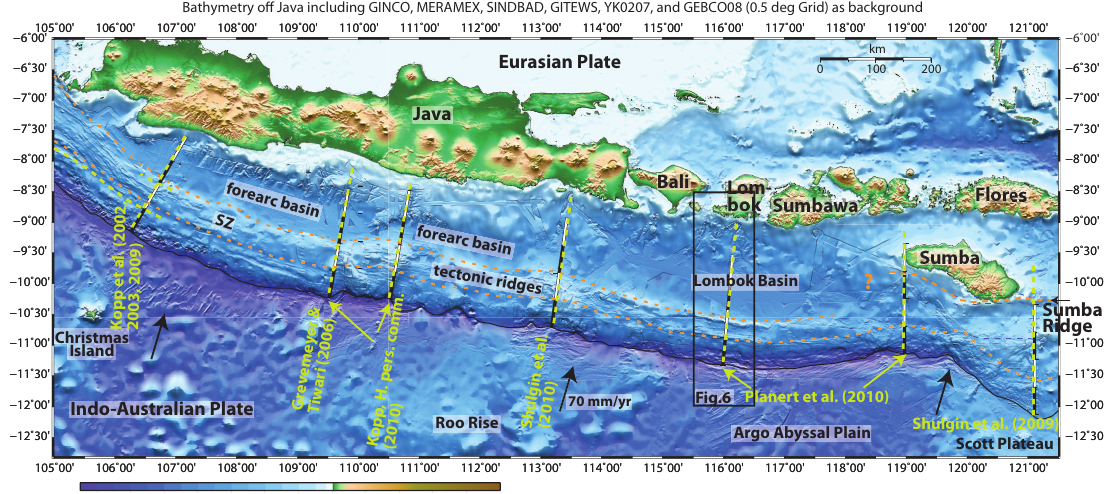
Fig. 3. Bathymetry off Java and the Lesser Sunda islands (multibeam bathymetry (for YK0207 see Soh et al., 2002), where available underlain by satellite derived bathymetry; Smith and Sandwell, 1997). Tectonic setting (after Newcomb and McCann, 1987) on the incoming plate as well as subduction direction and velocity (after Simons et al., 2007) are indicated by annotated black arrows on Indo-Australian plate. Lesser Sunda islands as well as major tectonic features are annotated along the forearc. Dashed lines sub-parallel to the trench mark the updip and downdip limit of the SZ. The seaward trench-parallel dashed line marking the updip limit of the SZ coincides with the slope break. Profiles and regions are marked and annotated, where additional investigations were available to constrain or refute their limits of the SZ. Deviations of the limits of the SZ from Grevemeyer and Tiwari (2006) by more than 10km are marked by dashed lines and discussed further in the text. 200km scales perpendicular to the trench help constrain distance from the deformation front. ? marks the transition, where no constraints exist on the depth of the downdip limit of the SZ most likely due to the presence of the Sumba block (Shulgin et al., 2009 and Planert et al., 2010). SZ – seismogenic